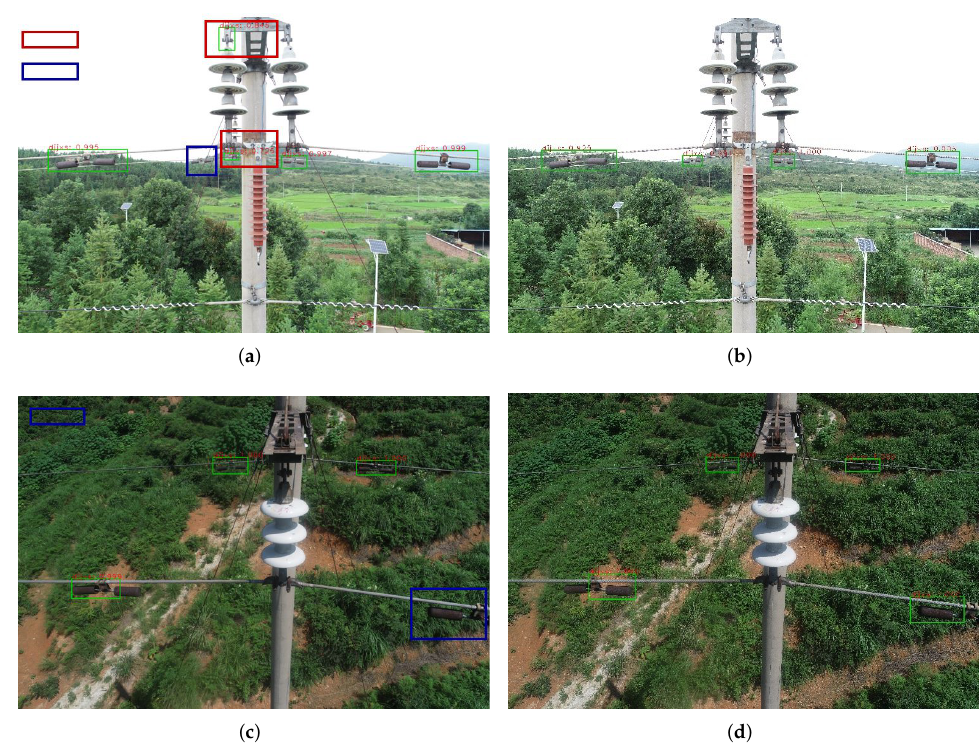
Figure 12. Comparative results of different backbone networks, where ( a , c ) are with VGG16, ( b , d ) are with